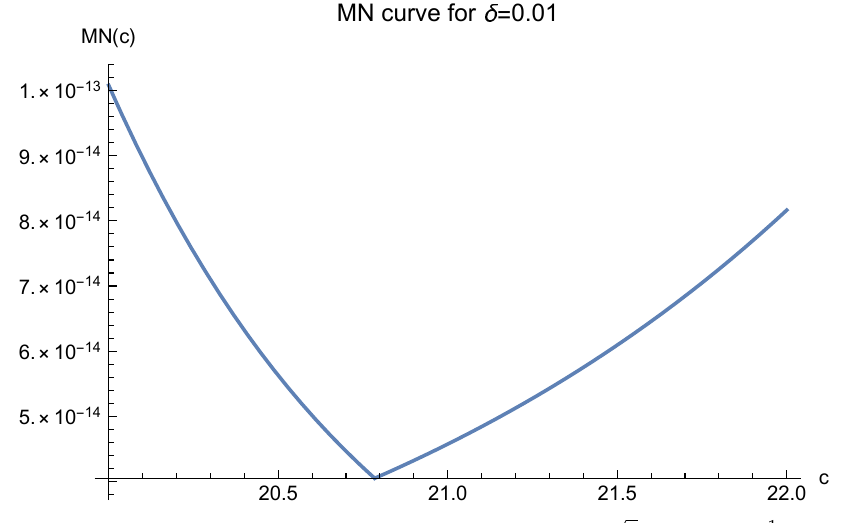
√ 3 and σ = 10 − 1 . MN curve for = 0.001 (cid:1)